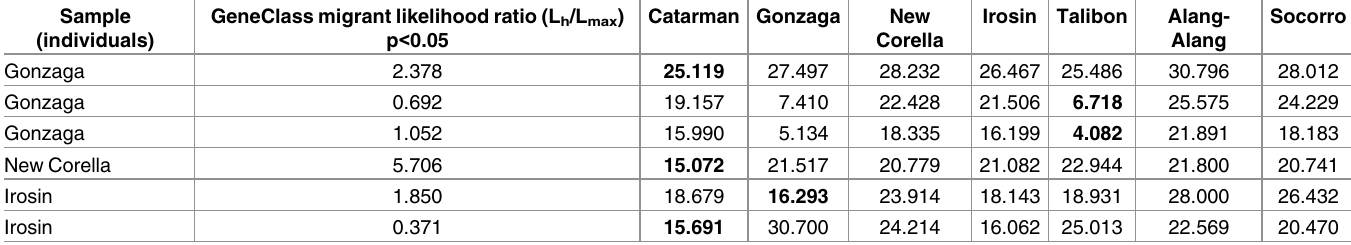
Table 4. Results of migrant detection analysis in GENECLASS a . Sample